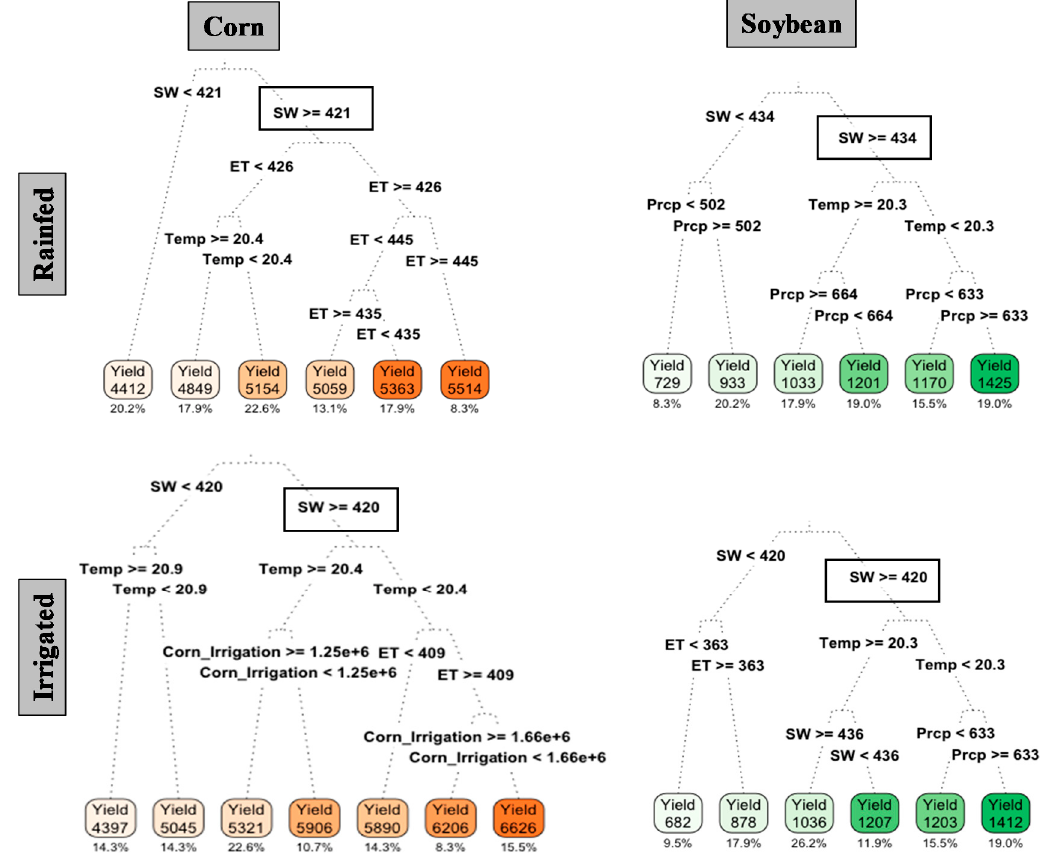
Figure 10. Outcomes from decision tree analysis for corn and soybean yield variations for rainfed and irrigated conditions under RCP 4.5. Precipitation (Prcp), evapotranspiration (ET), and soil water (SW) storage are presented in mm, and temperature (temp) is presented in °C. Corn and soybean yields are represented by orange and green color, respectively. Crop yields are presented in kg/ha, and the percentages are the fraction of total crop yield in each node.